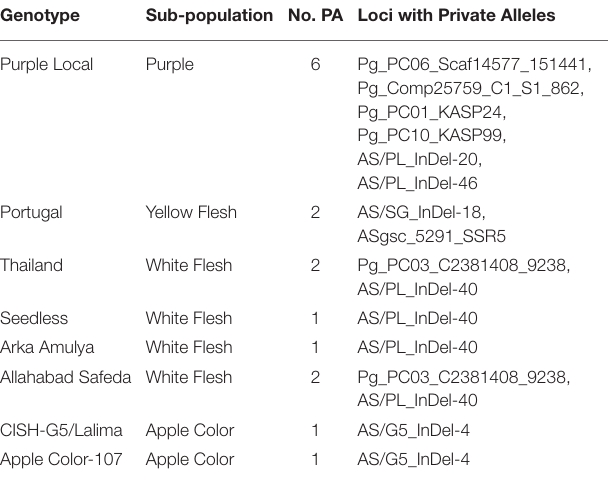
TABLE 5 | Distribution of private alleles in the 22 Psidium guajava genotypes.